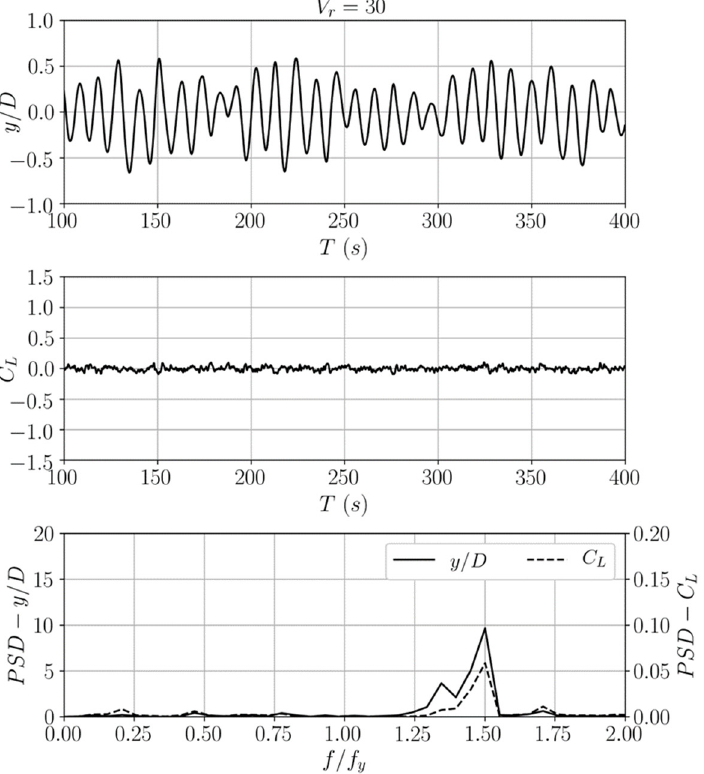
Figure 10. Time series and PSD of transverse response and force coefficient of FOWT platform with α = 0 ◦ , at various V r .